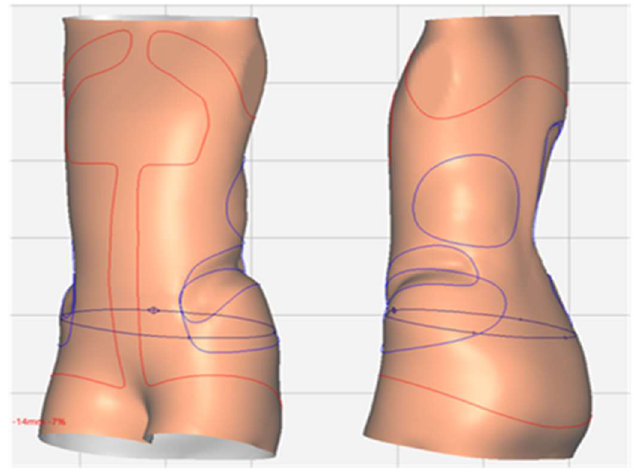
Figure 3. CAD design using a specialized software for O&P products (Neo, Rodin4D, Merignac, France).